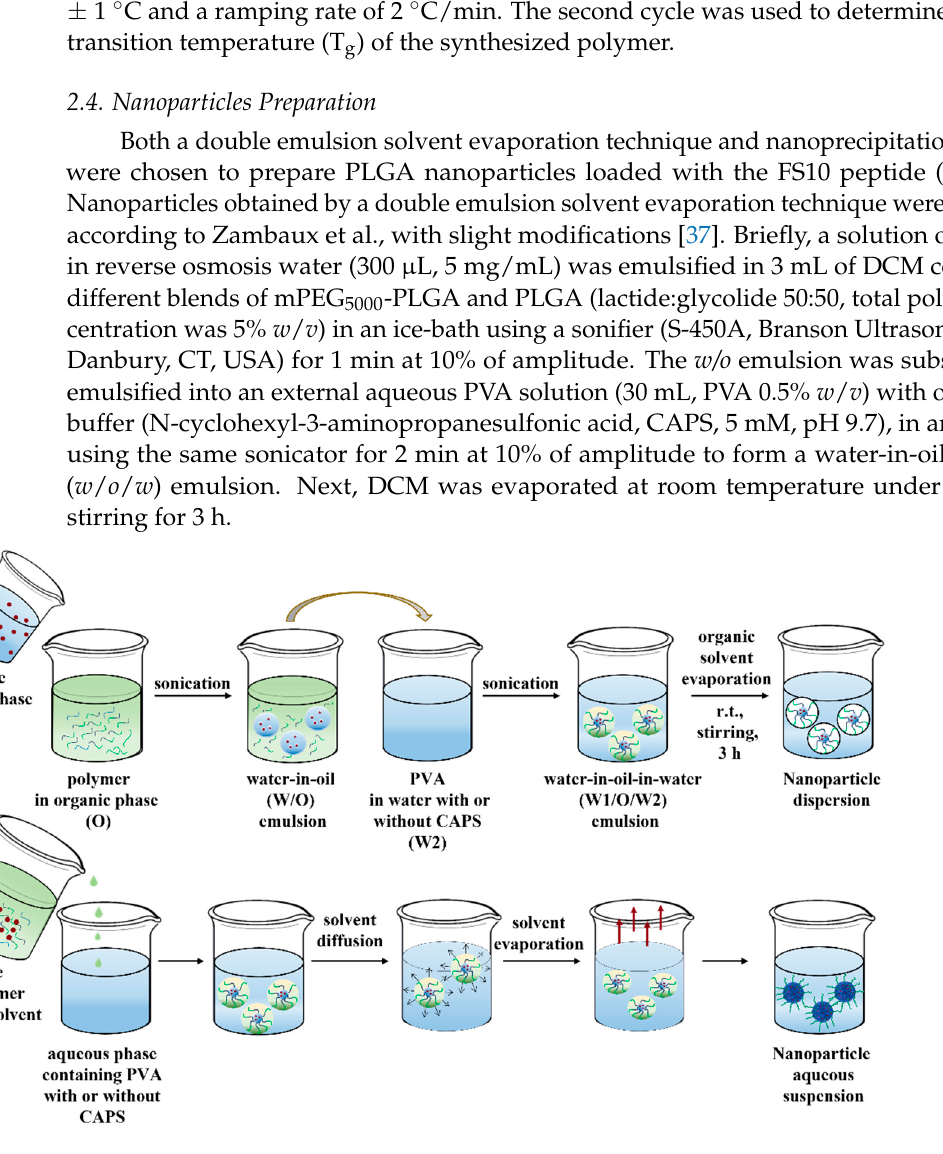
Figure 2. FS10-loaded Nps prepared by ( A ) double emulsion and ( B ) nanoprecipitation methods. The Nps obtained both with the double emulsion and nanoprecipitation methods were collected by ultracentrifugation (40,000× g for 30 min) and washed twice with 20 mL reverse osmosis water. Nps obtained from both procedures were lyophilized and stored at − 20 °C. All formulation batches were prepared in triplicate.